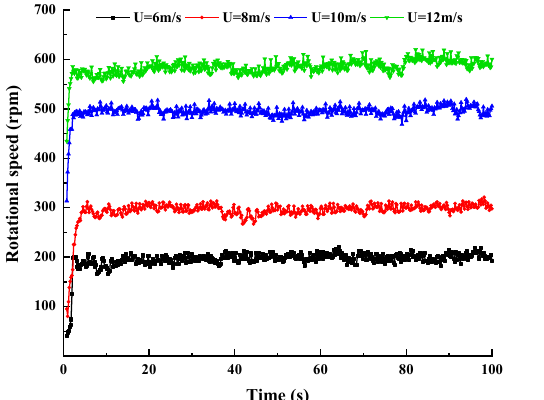
Figure 13. Rotating characteristics of spiral wind turbine under various incoming wind speeds.